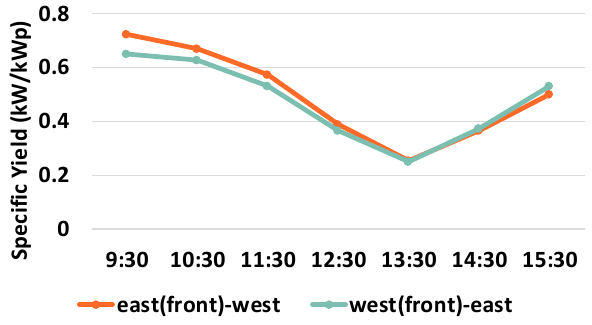
Figure 4. Specific yield based on front side orientation.